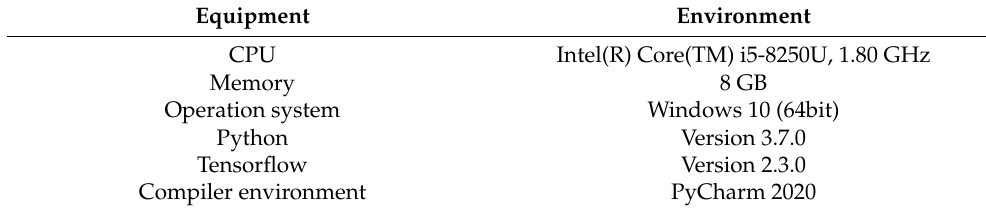
Figure 3. Transfer leaning method for MobileNetV2.